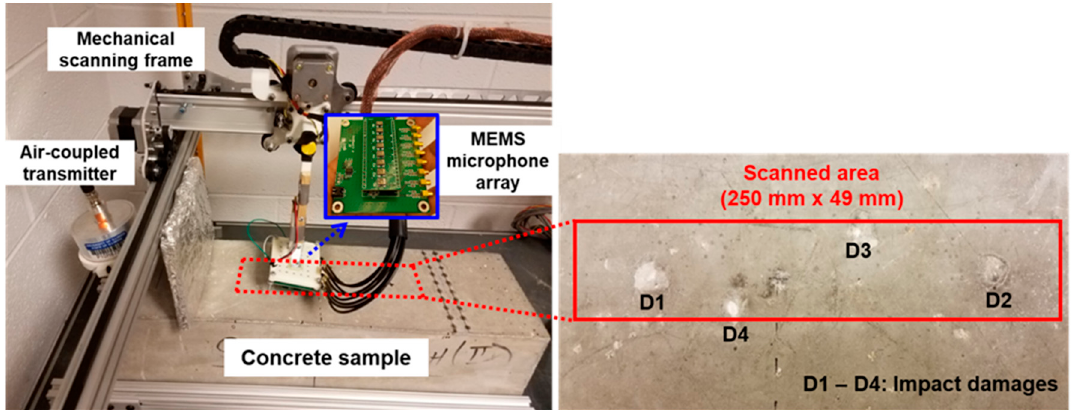
Figure 1. The contactless scanning ultrasound measurement hardware ( left ) and the concrete sample ( right ) that shows impact damage locations; ultrasonic scan area indicated by red box. Impact damage points were introduced sequentially from the position D1 to D4.